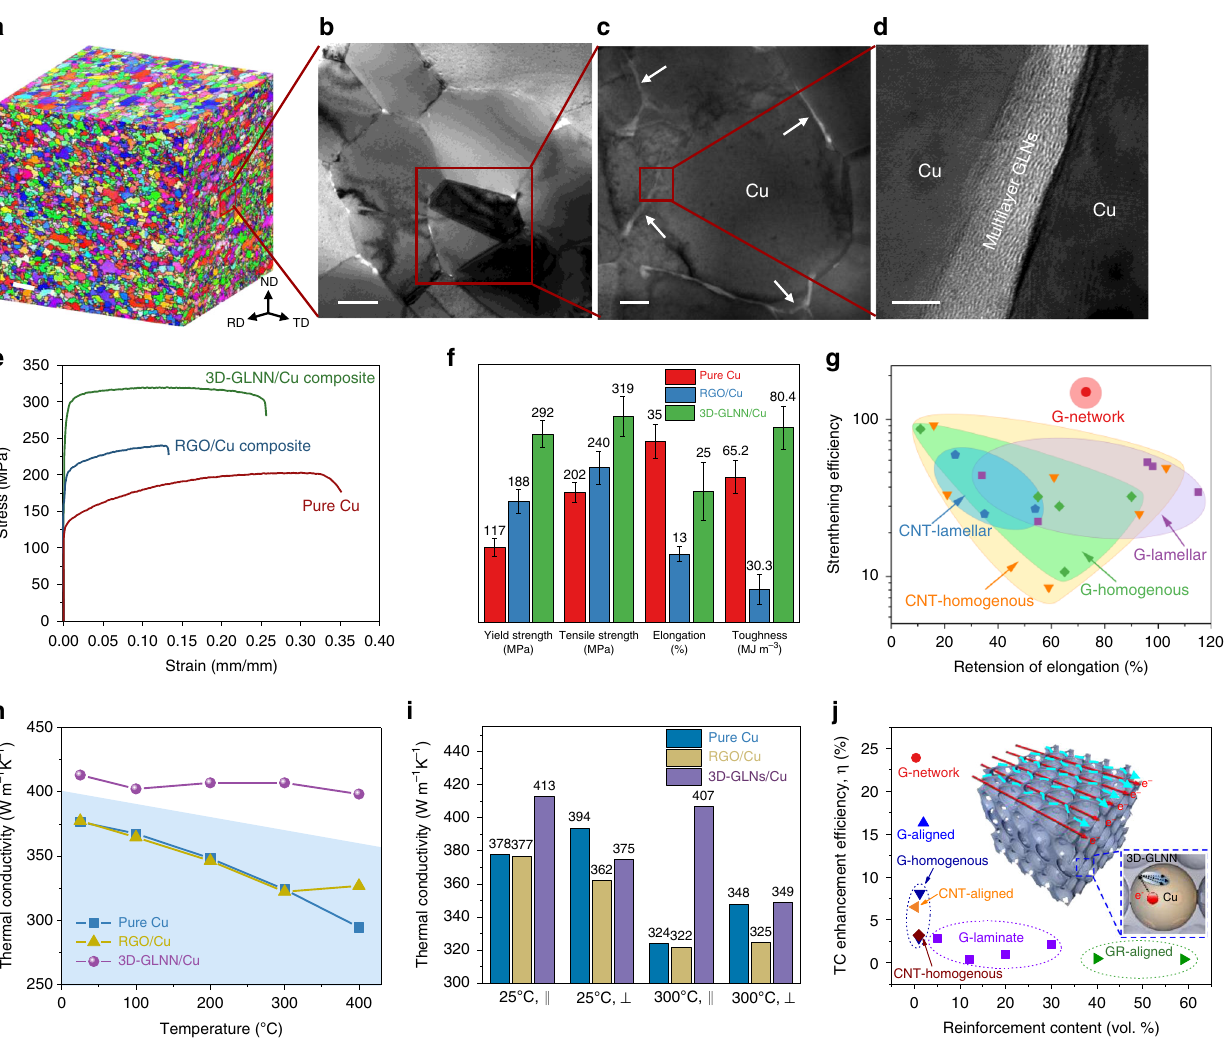
Fig. 5 Typical microstructures and performance. a EBSD micrographs of hot-rolled 3D-GLNN/Cu from three orthogonal directions. Scale bar, 5 μ m. b Bright- fi eld TEM image of the 3D-GLNN/Cu composites. Scale bar, 500 nm. c , d Bright- fi eld scanning transmission electron microscope (STEM) image of the 3D-GLNN/Cu composites ( c ) and the corresponding HRTEM image taken near the grain boundaries of the composite ( d ). Scale bar, 200 nm ( c ); 5 nm ( d ). e Tensile stress-strain curves of pure Cu, RGO/Cu, and 3D-GLNN/Cu. f Comparative bar chart of mechanical properties of pure Cu, RGO/Cu, and 3D- GLNN/Cu. g Retention of fractural elongation versus strengthening ef fi ciency of tensile strength plot, showing that the as-prepared 3D-GLNN/Cu composite had an outstanding combination of strengthening ef fi ciency and ductility. h The in-plane thermal conductivities of pure Cu, RGO/Cu, and 3D- GLNN/Cu. i Comparative bar chart of thermal conductivities of pure Cu, RGO/Cu, and 3D-GLNN/Cu at room temperature (25 °C) and 300 °C. j TC enhancement ef fi ciency versus graphene content plot, demonstrating a high enhancement ef fi ciency of 3D-GLNN in thermal conductivity at a relatively small graphene content compared with other reported nanocarbon reinforced Cu matrix composites. Inset is the illustration of the electrons and phonons transfer channels in 3D-GLNN and the reduction of electrons scattering in the Cu matrix near the